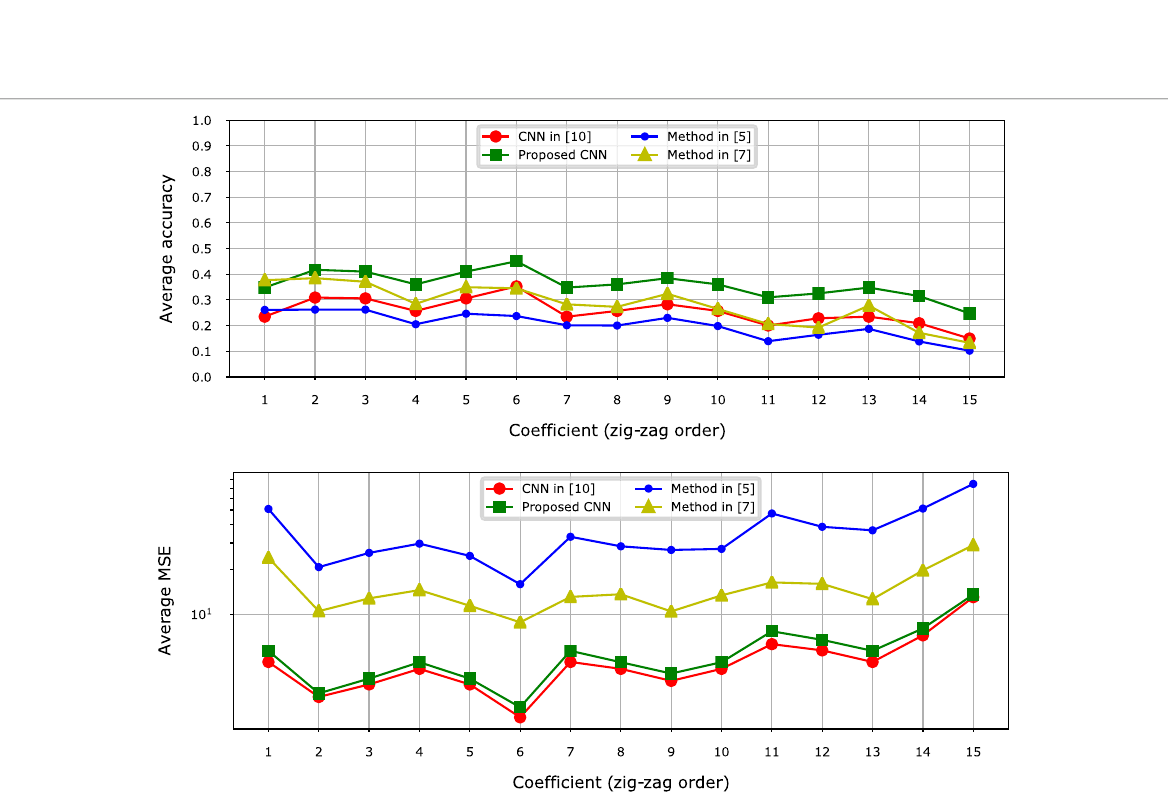
Fig. 7 Average accuracy (top) and MSE (bottom) of the estimation for each of the 15 DCT coefficients, for QF 2 = 80, in the aligned DJPEG